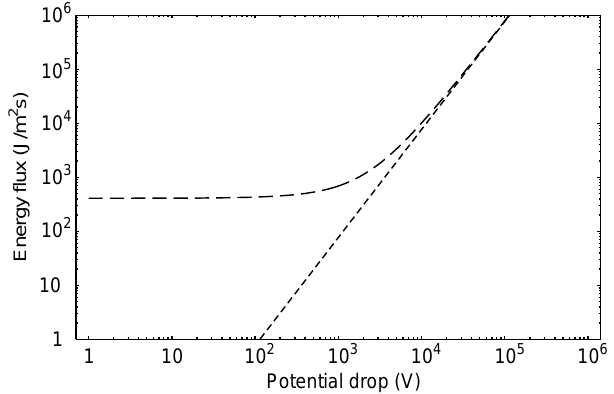
Fig. 6. Same as Fig. 4 but for the energy flux. The dashed line is the first approximation and the dotted line is the second approximation. The exact formula for the kappa energy flux is not known, so there is no